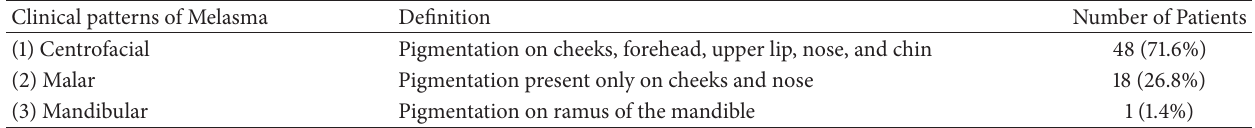
Table 3: Clinical patterns of Melasma as observed in this study.